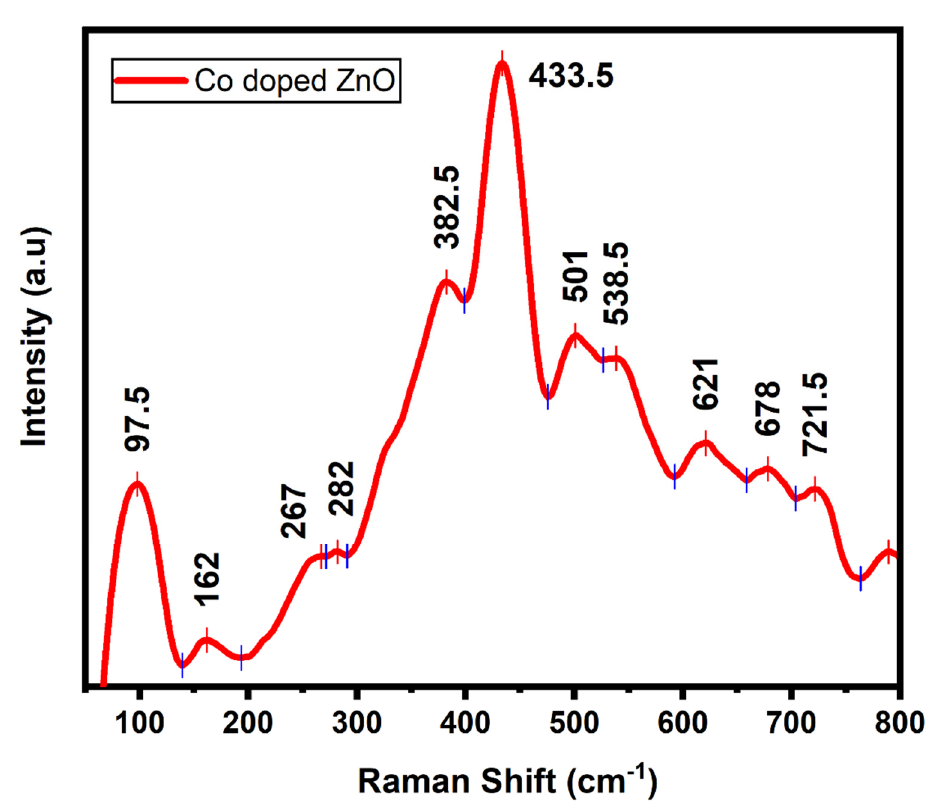
Figure 5. Raman spectrum of Co-doped ZnO microcrystals (MCs).